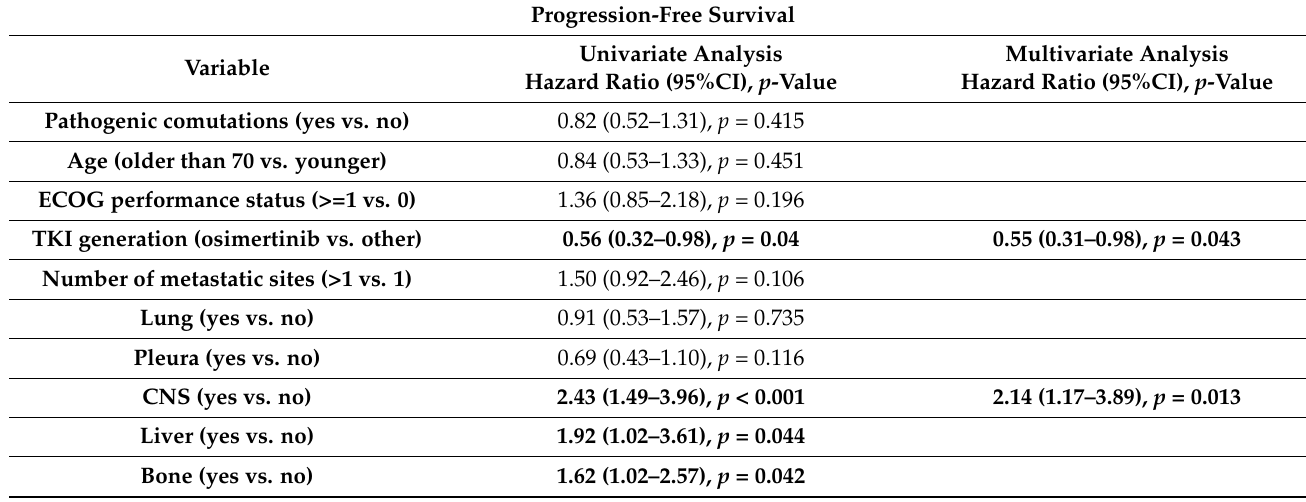
Table 2. Univariate and multivariate analysis for progression-free survival. Bold indicates statistically significant findings ( p <